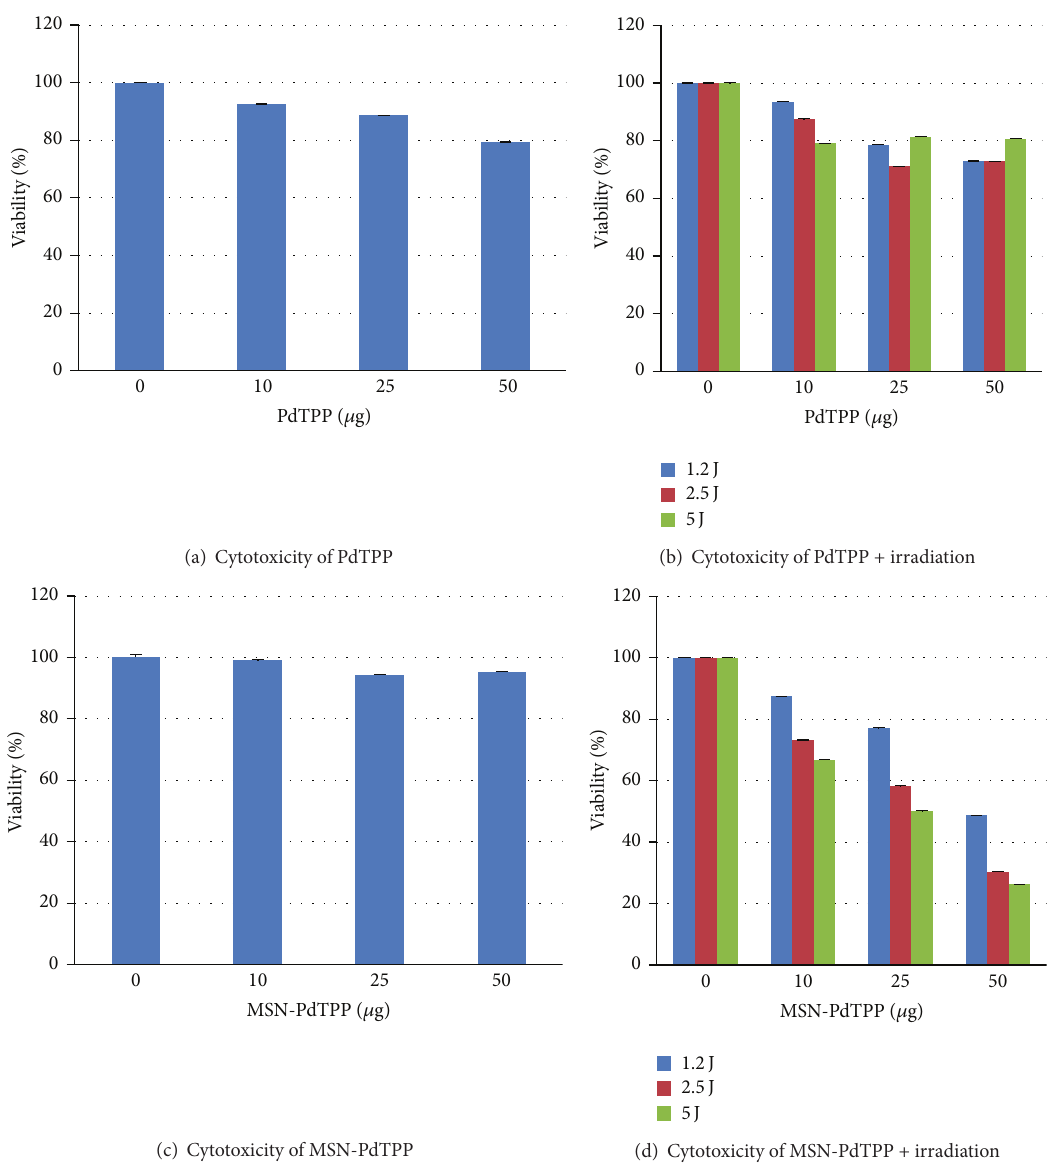
Figure 3: Dark (nonilluminated) cytotoxicity of MDA-MB-231 cells treated with various concentrations of (a) PdTPP and (c) MSN-PdTPP. Illumination cytotoxicity of MDA-MB-231 cells treated with various concentrations of (b) PdTPP and (d) MSN-PdTPP following 1.2 J, 2.5 J, and 5J of